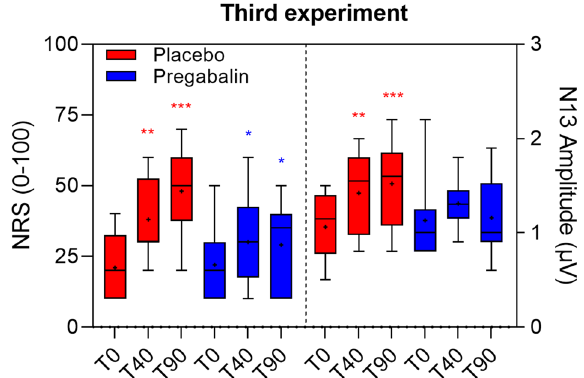
Figure 3. Experiment 3: Crossover trial assessing how pregabalin prevents capsaicin-induced modulation of N13 somatosensory evoked potentials (SEPs) and Secondary Hyperalgesia. Boxplots of the N13 amplitudes and magnitude of secondary hyperalgesia (NRS 0–100) at different time points (placebo in red, pregabalin in blue). Pregabalin prevented capsaicin induced facilitation of N13 and attenuated that of hyperalgesia ratings. Black lines represent medians, crosses represent means. Asterisks indicate significance vs. baseline (Sidak-corrected p-value), *p < 0.05, **p < 0.01, ***p <